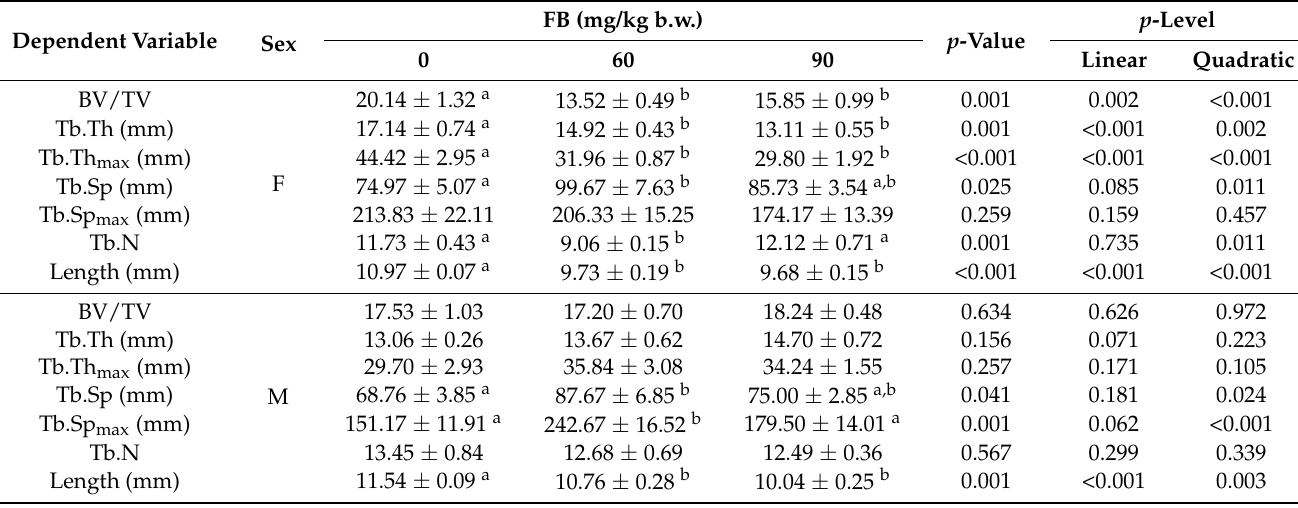
Table 1. The trabecular bone histomorphometry of rat offspring following maternal exposure to 0, 60 and 90 mg/kg b.w. of